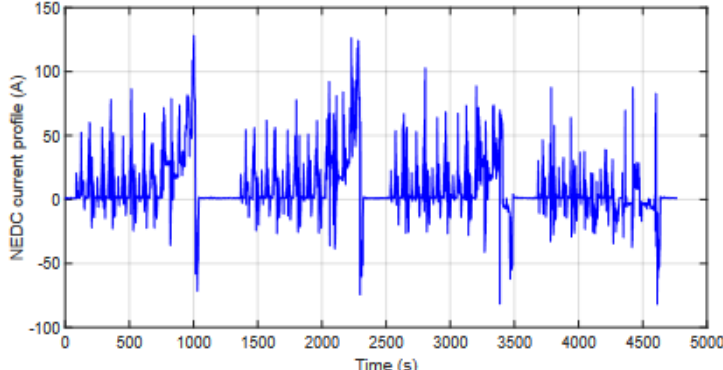
Figure 9. NEDC battery current profile from data recorded on chassis dynamometer.